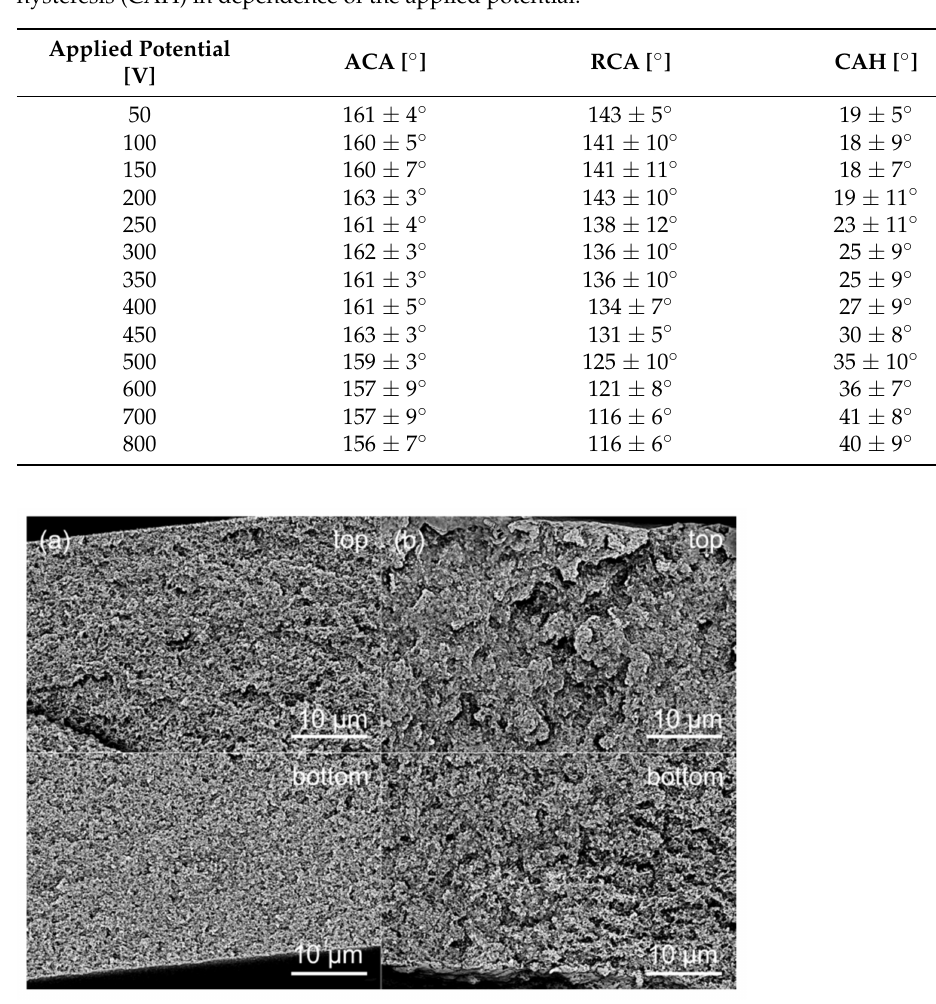
Figure A1. Cross-sectional micro-graphical images of Fluoropor with different thickness, showing the porous structure throughout the bulk material: ( a ) Fluoropor film of 75 µ m and ( b ) 150 µ m thickness (sections from the top and bottom of the material were chosen